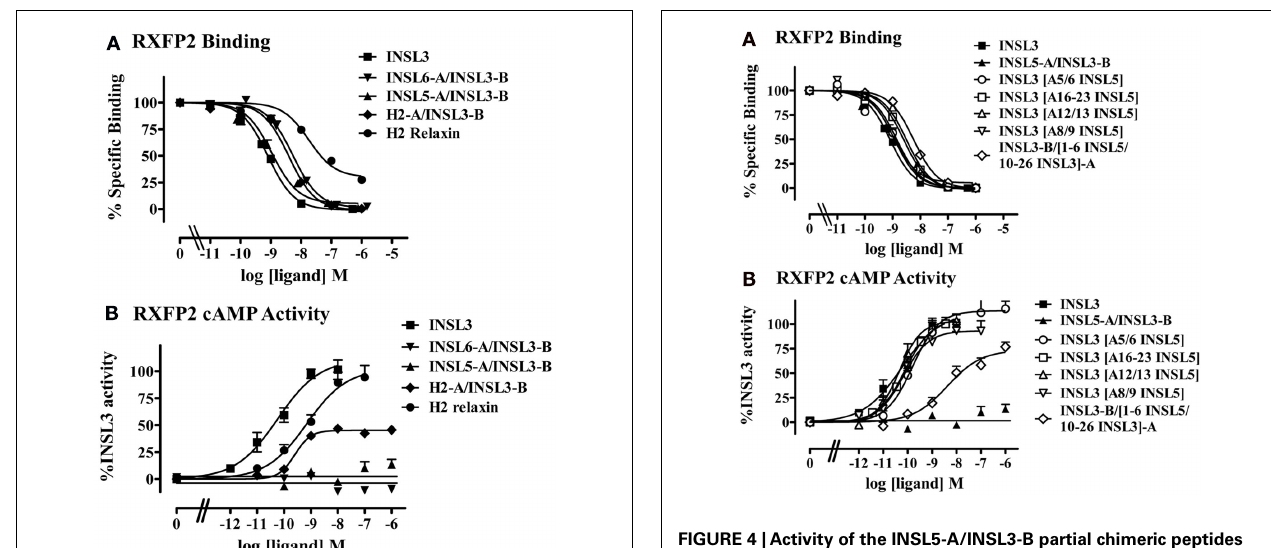
FIGURE 4 |Activity of the INSL5-A/INSL3-B partial chimeric peptides on the RXFP2 receptor. (A) Competition binding utilizing Eu-labeled INSL3 compared to INSL3 and H2 relaxin. Data are expressed as the percentage of specific binding and are pooled from at least three experiments with triplicate determinations within each assay. (B) cAMP activity compared to INSL3 and H2 relaxin measured utilizing a pCRE– β -galactosidase reporter gene assay. Data are expressed as the percentage INSL3 maximum activity and are pooled data from at least three experiments with triplicate determinations within each